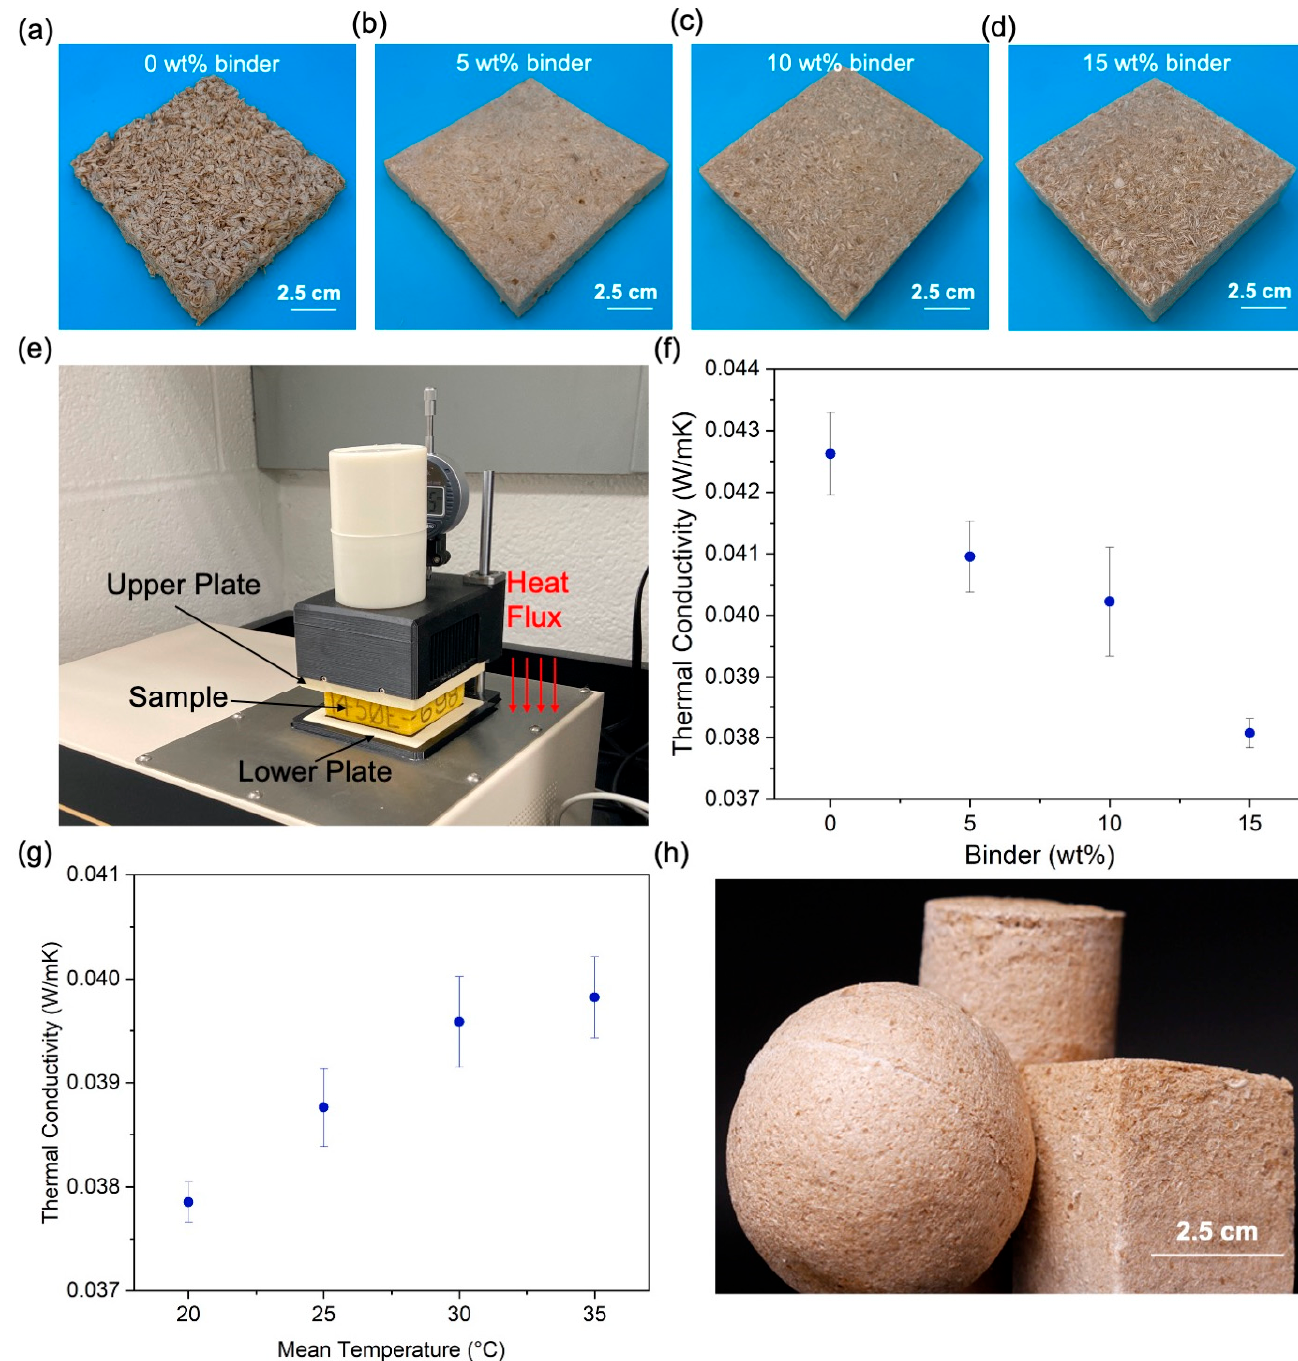
Figure 4. Thermal insulation performance. Delignified wood chip foam samples with varied CMC binder content, including ( a ) 0 wt.% binder, ( b ) 5 wt.% binder, ( c ) 10 wt.% binder, and ( d ) 15 wt.% binder. ( e ) HFM-25 apparatus. ( f ) Thermal conductivity of delignified wood chip foam versus CMC binder content. ( g ) Thermal conductivity of 15 wt.% CMC binder delignified wood chip foam versus mean temperature. ( h ) Wood chip foams with different shapes.